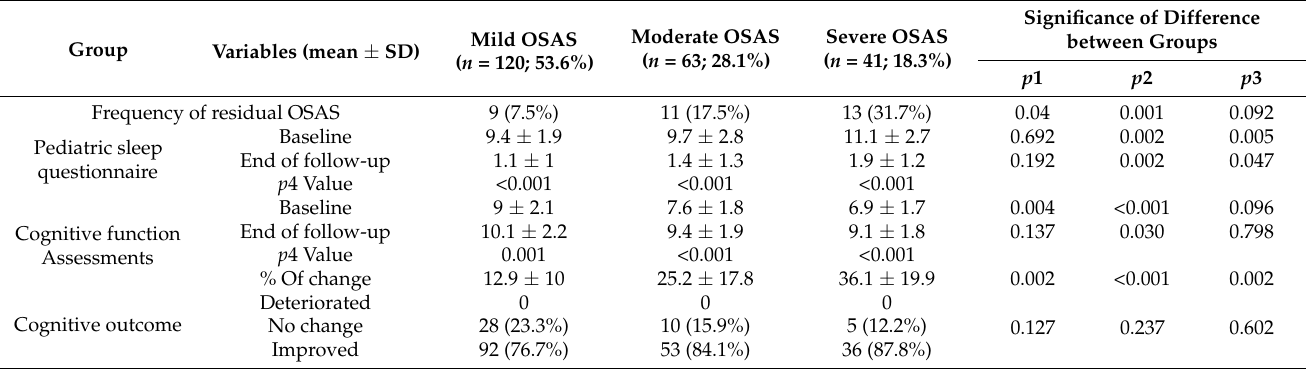
Table 2. Outcome of the applied management of studied patients categorized according to OSAS